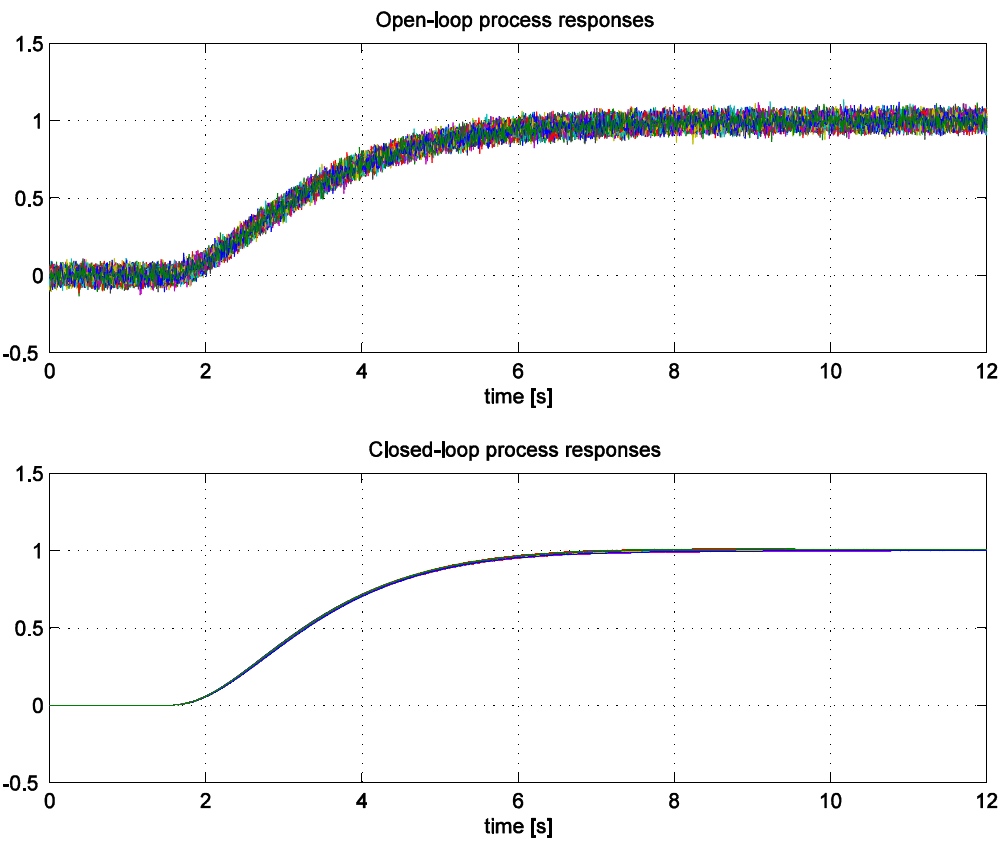
Figure 11. Histograms of the calculated controller parameters for 100 runs in noisy open-loop re- sponses obtained using the FWLS method. The values of the controller parameters obtained with undisturbed open-loop responses without noise are represented by red circles.